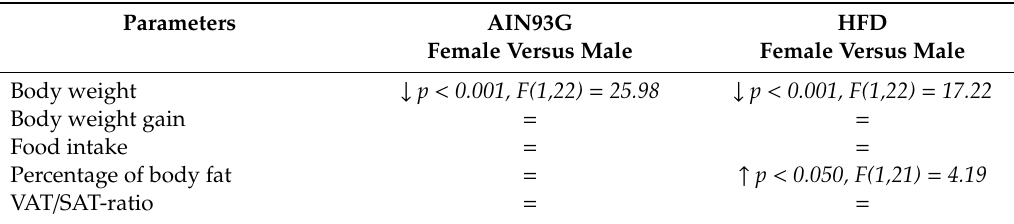
Table 3. Overview of p - and F -values of significant e ff ects between male and female mice fed either a AIN93G diet or 18 weeks of high fat diet